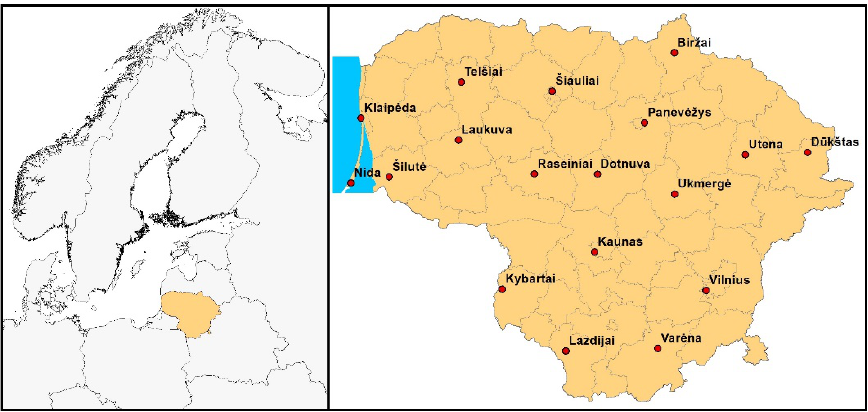
Fig. 1. Location of meteorological stations whose data were used in this